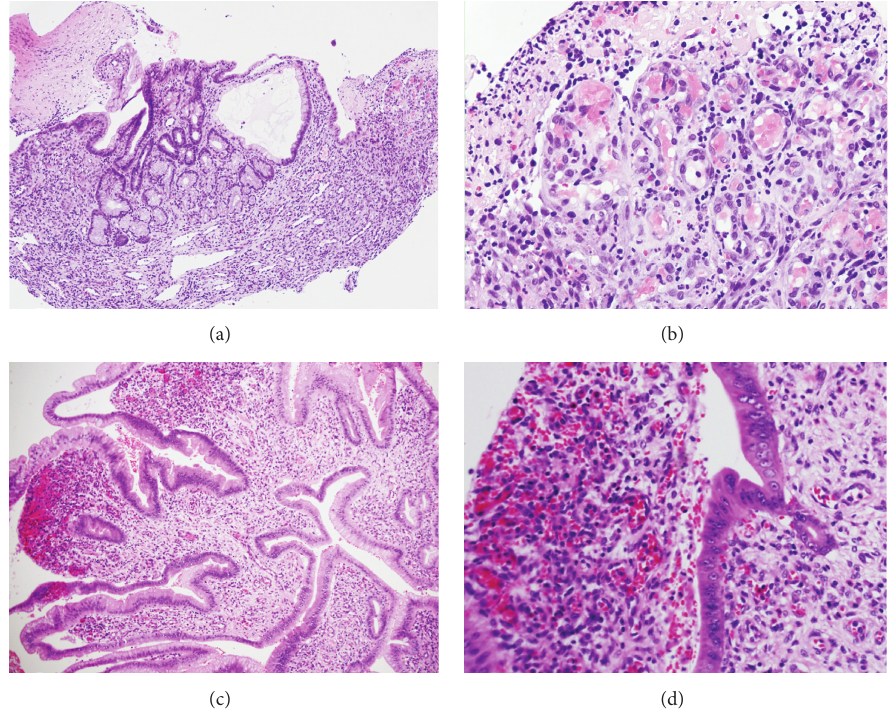
Figure 3: (a-b) Pyogenic granuloma of the stomach (Case 3 ). (c-d) Pyogenic granuloma of the ileum (Case 4 ). Low power views ((a) and (c), H&E, 100x) reveal gastrointestinal mucosa with variable ulceration. High power ((b) and (d), H&E, 400x) exhibits lobular arrangement of capillary proliferation and active